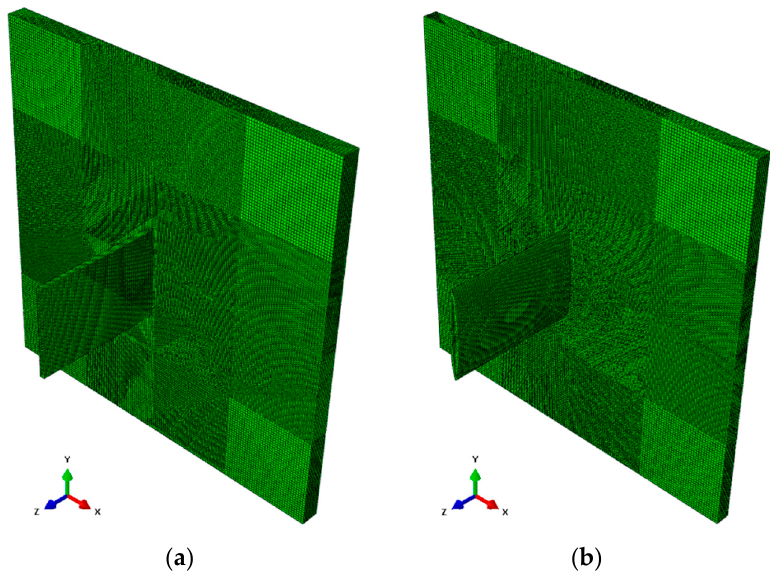
Figure 8. ( a ) Exact mesh used for the 2618 aluminum alloy plates and the Ti-6Al-4V solid plate projectile and a hollow blade projectile; and ( b ) exact mesh used for the 2618 aluminum alloy plates and the Ti-6Al-4V hollow blade projectile.